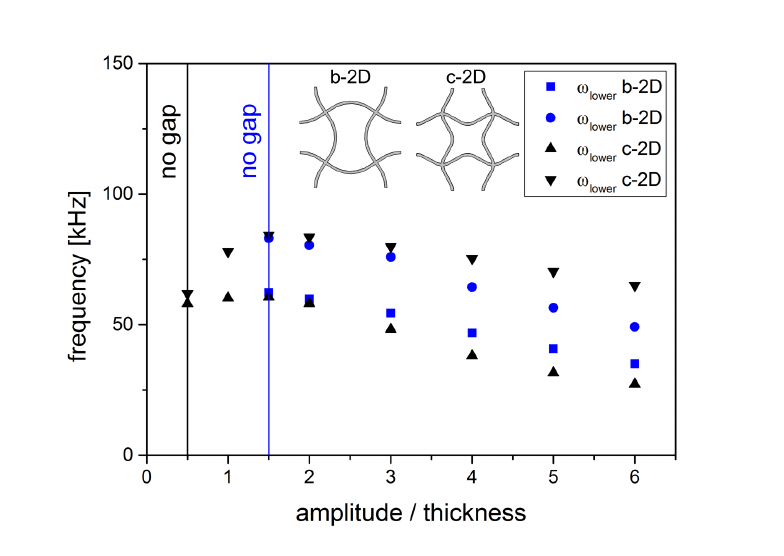
Figure 10. Upper and lower frequencies of the 1st band gap for structure b-2D and c-2D in dependancy of the amplitude A (l = 5.0 mm, d = 0.25